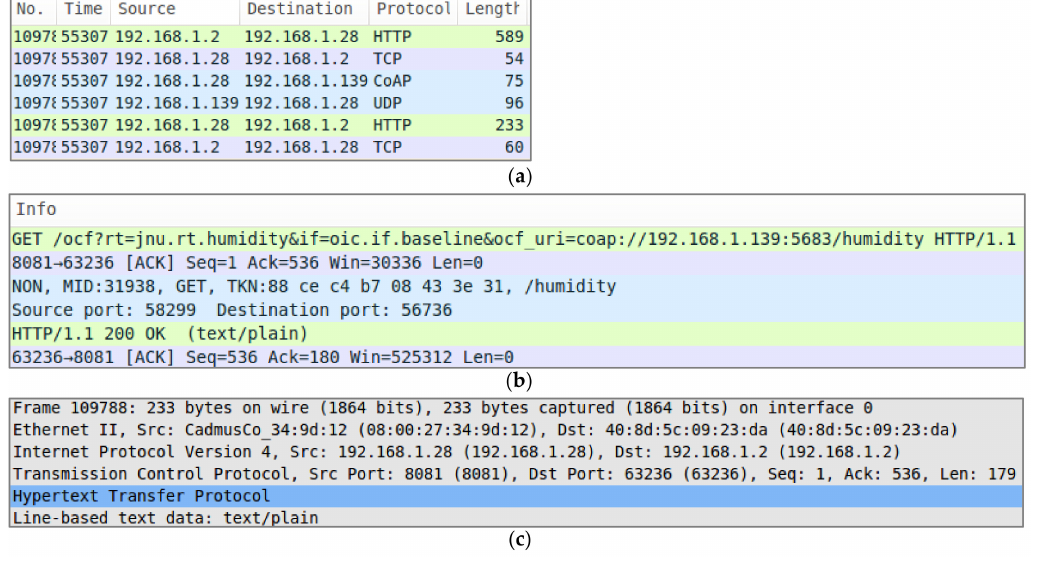
Figure 17. Network packet capture of requesting OCF device through IoT server. ( a ) Network request and response packet list. ( b ) Packet details. ( c ) Hypertext Transfer Protocol (HTTP) response message.